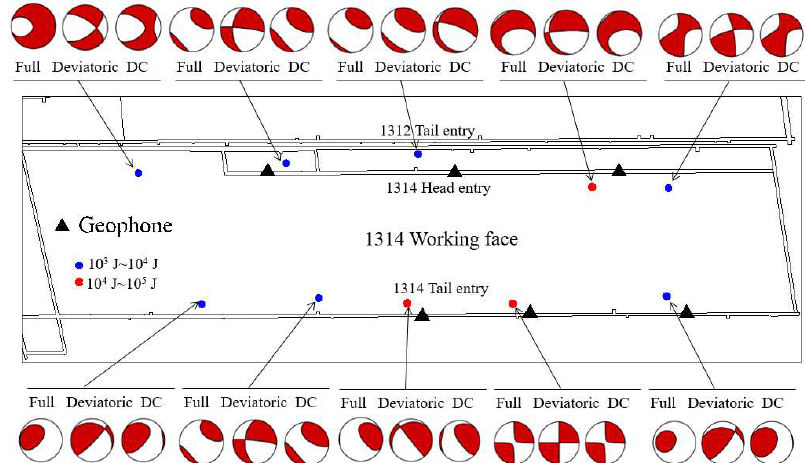
Figure 20. Beachballs in the 1314 working face.